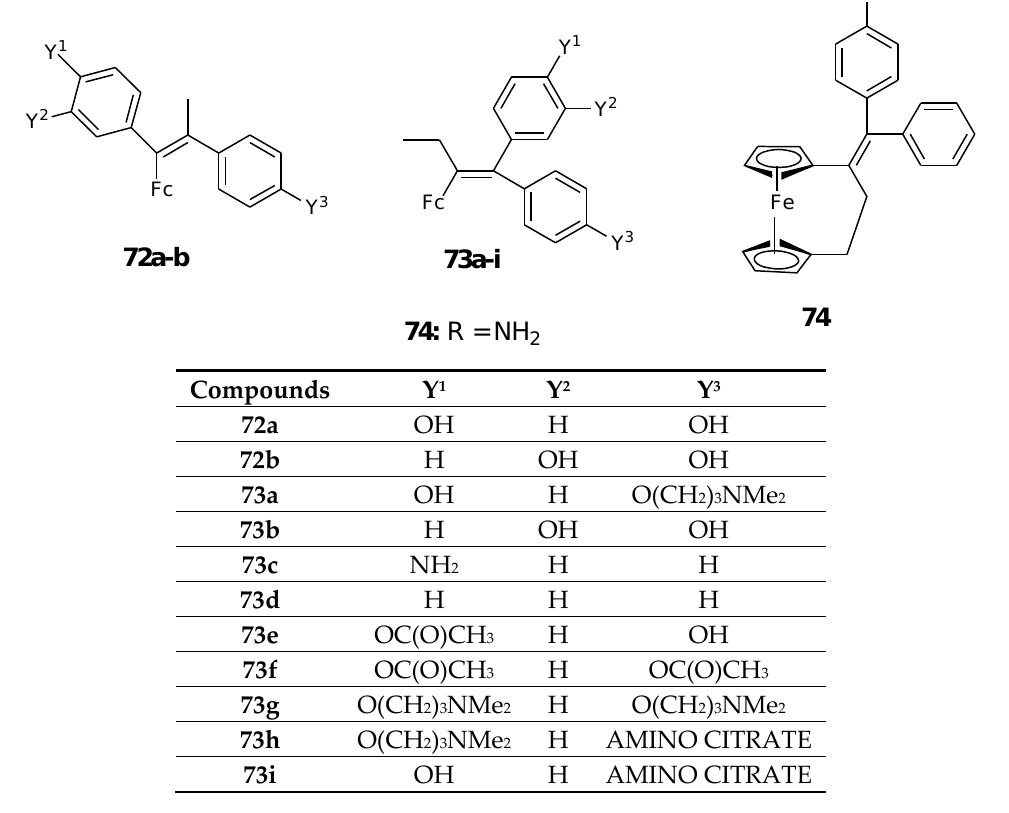
Figure 25. Chemical structures of ferrocenyl – olefins ( 72 – 74 ).